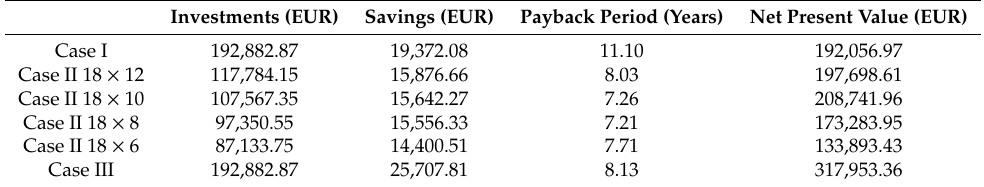
Table 8. The payback period and net present value for the cases